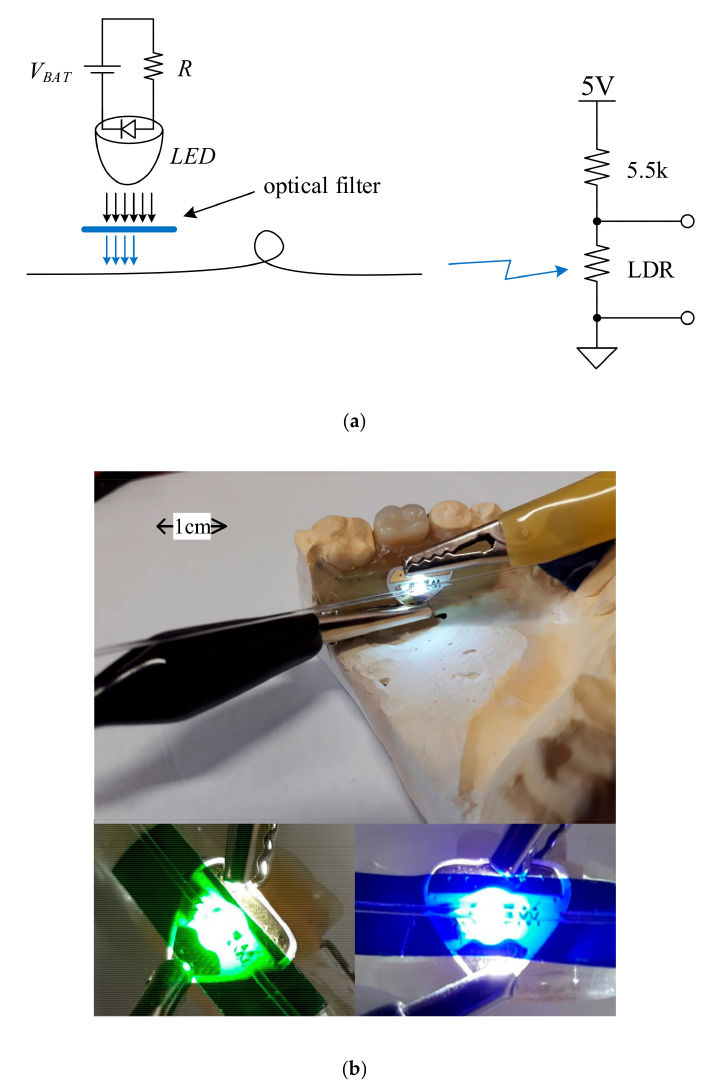
Figure 8. Test setup for the assessment of the point intra-oral sensor spectral attenuation measures: ( a ) schematic diagram, ( b ) practical realization with external LED supply and optical filter